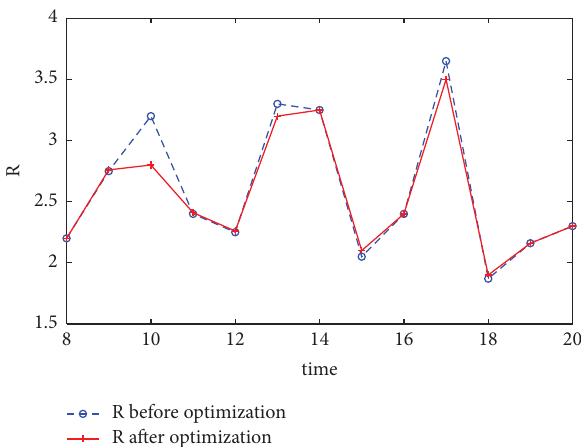
Figure 20: Comparison chart of R before and after optimization.